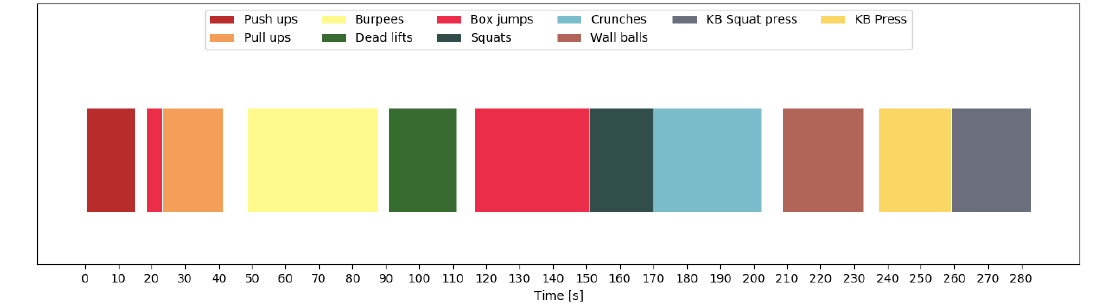
Figure 12. Chronological sequence of recognized exercises during free workout 1 for P1.